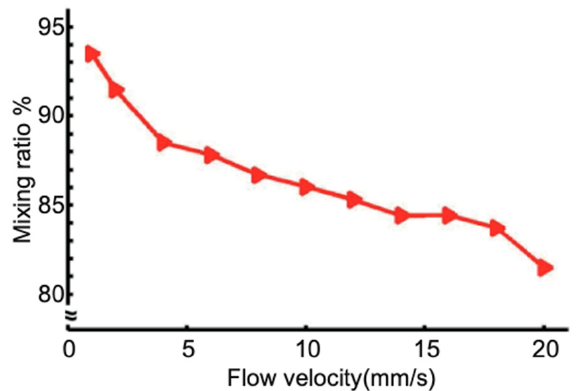
Figure 5. The relationship between mixing ratio after 4 cycles and flow velocity.